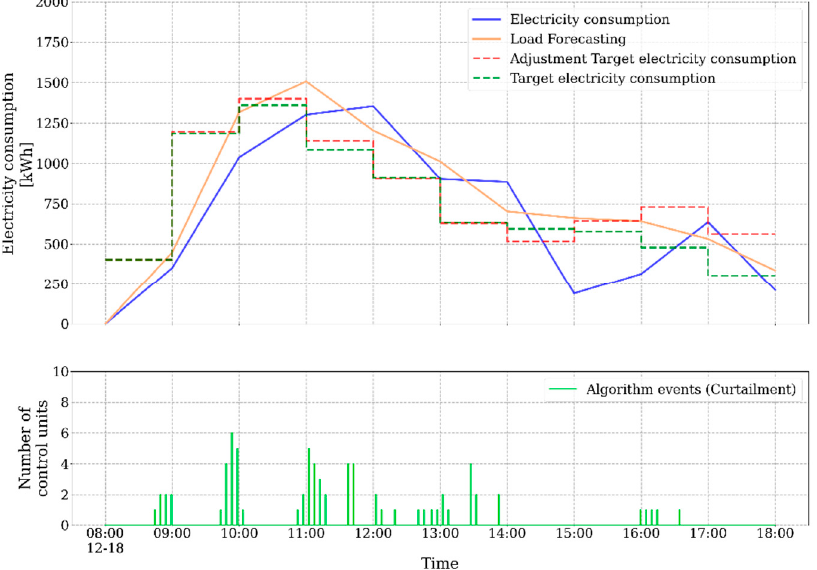
Figure 20. Reduction ratio 15% result of the field test with the target, building electricity consumption, and algorithm events applying the building control algorithm.